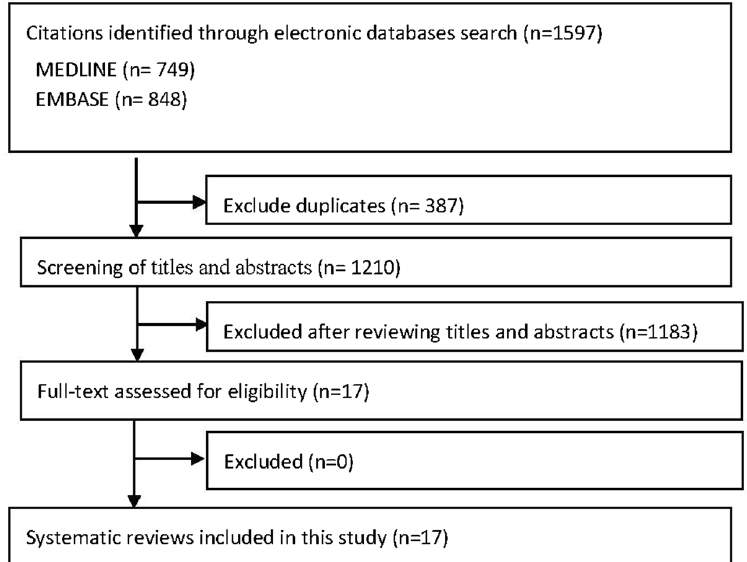
Figure 1. Flowchart of literature selection on systematic reviews of acupuncture related adverse